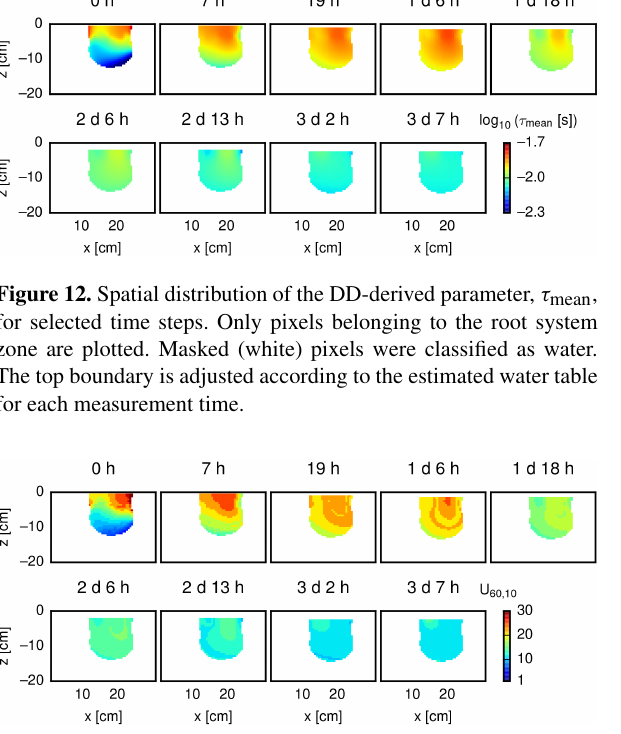
Figure 13. Spatial distribution of the DD-derived parameter, U 60 , 10 , for selected time steps. Only pixels belonging to the root system zone are plotted. Masked (white) pixels were classified as water. The top boundary is adjusted according to the estimated wa- ter table for each measurement